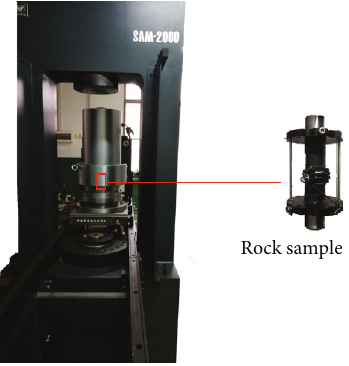
Figure 1: SAM-2000 triaxial testing